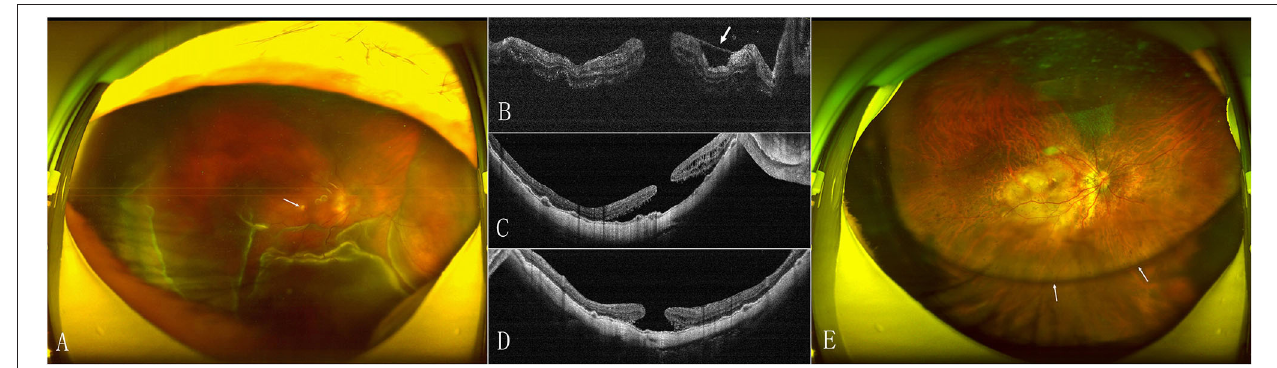
FIGURE 3 | Preoperative and postoperative SLO and OCT images of the eye of a 66-year-old woman with MHRD in the adjustable positioning group. (A) Preoperative SLO shows the RD with MH (arrow) beyond vascular arcade. (B) OCT confirms the MHRD with an epiretinal membrane (arrow). (C) OCT at 6 months after surgery shows that the MH still open and the extent of RD is narrowed. (D) Twenty one months later, OCT shows the MH is not closed and the retina around the MH is not reattached. (E) Postoperative SLO at 21 months shows that the silicon oil has not been removed yet